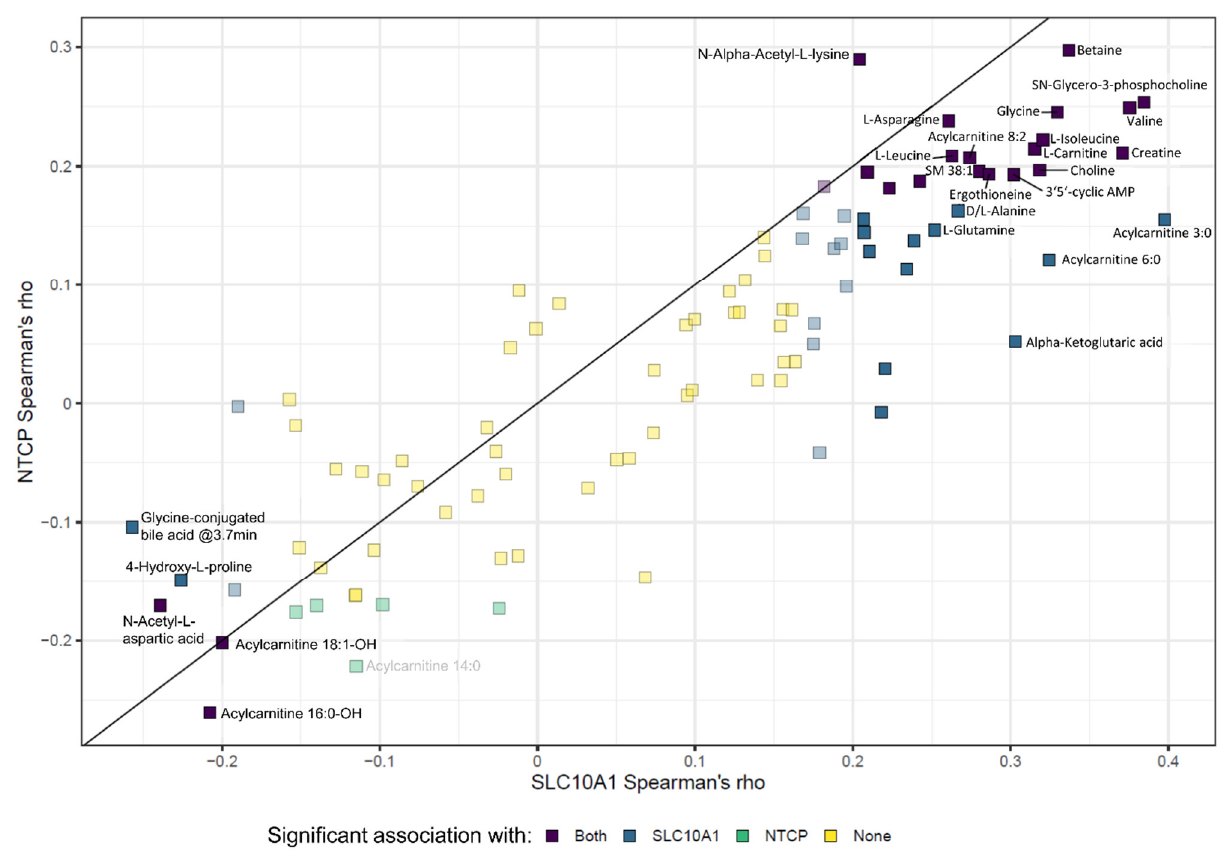
Figure 7. SLC10A1 /NTCP expression and hepatic metabolism. Spearman correlations between mRNA expression and protein levels and endogenous metabolites in the 143 liver samples. SLC10A1 mRNA expression was measured by qPCR and protein abundance was analyzed through LC-MS/MS. Metabolite levels were quantified using LC-MS technology. Correlations higher than 0.25 or lower than − 0.2 are labeled, whereas correlations not significant after adjustment for multiple testing using the Benjamini-Hochberg procedure are only weakly colored.